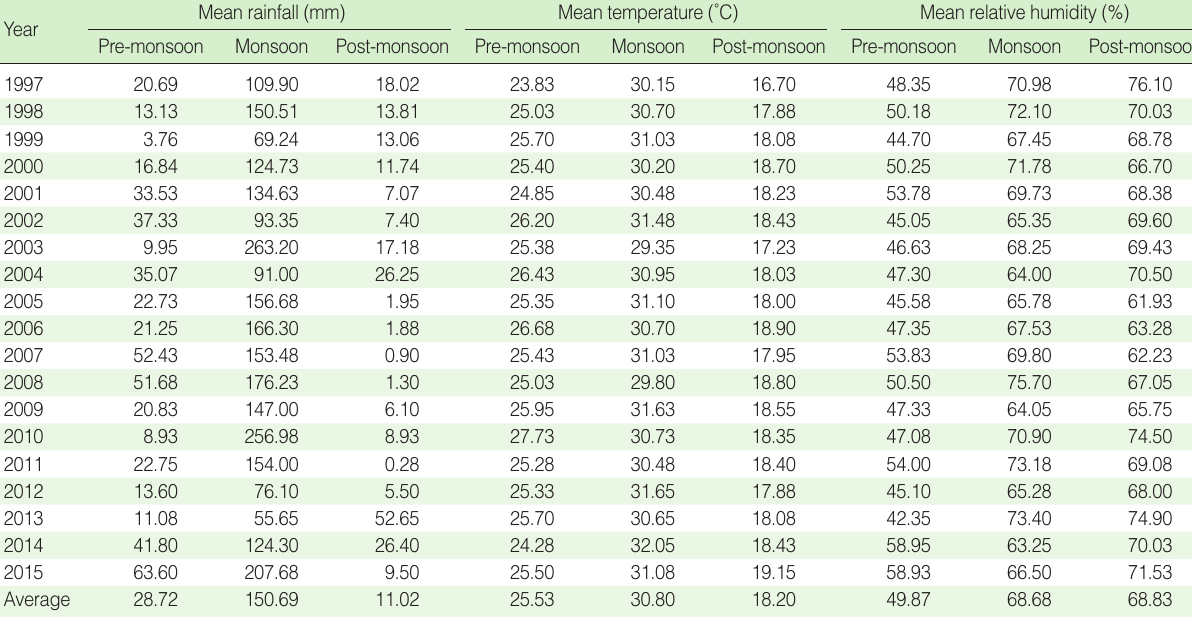
Figure 1. Average number of dengue cases and rainfall by month from 1997 to 2015. Table 2. Distribution of climatic parameters by season